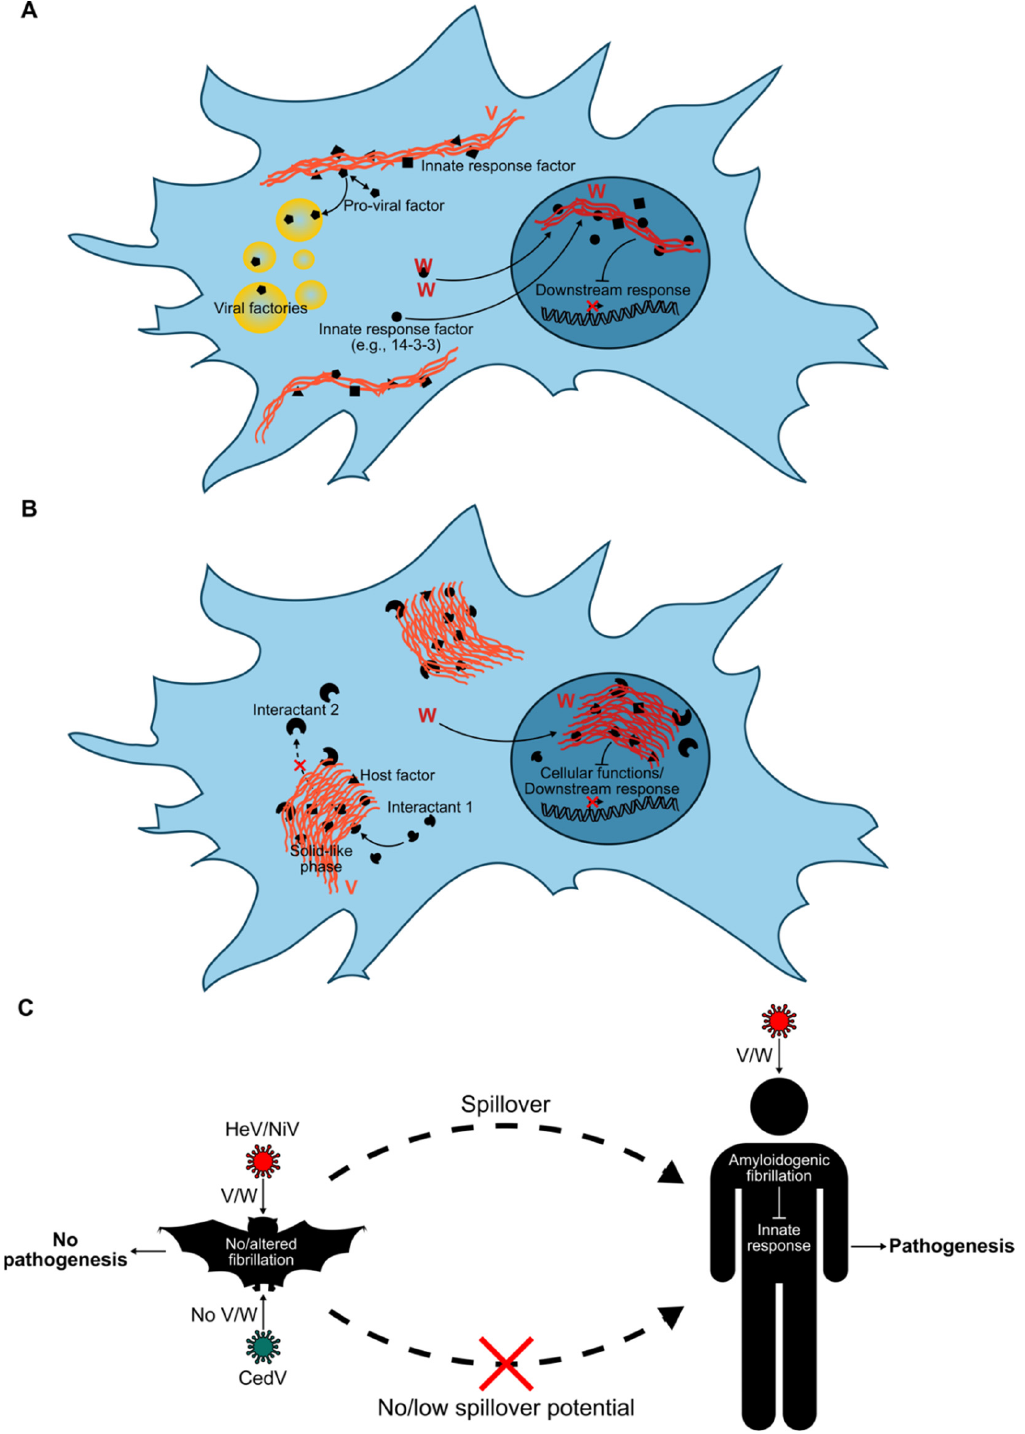
Figure 2. Involvement of viral non-structural protein amyloidogenesis in immune response blockage and spillover potential. ( A ) As an example of fibrillation-prone viral proteins interfering with host cell functions, Henipavirus V and W are proposed to form fibrillar filaments with properties of